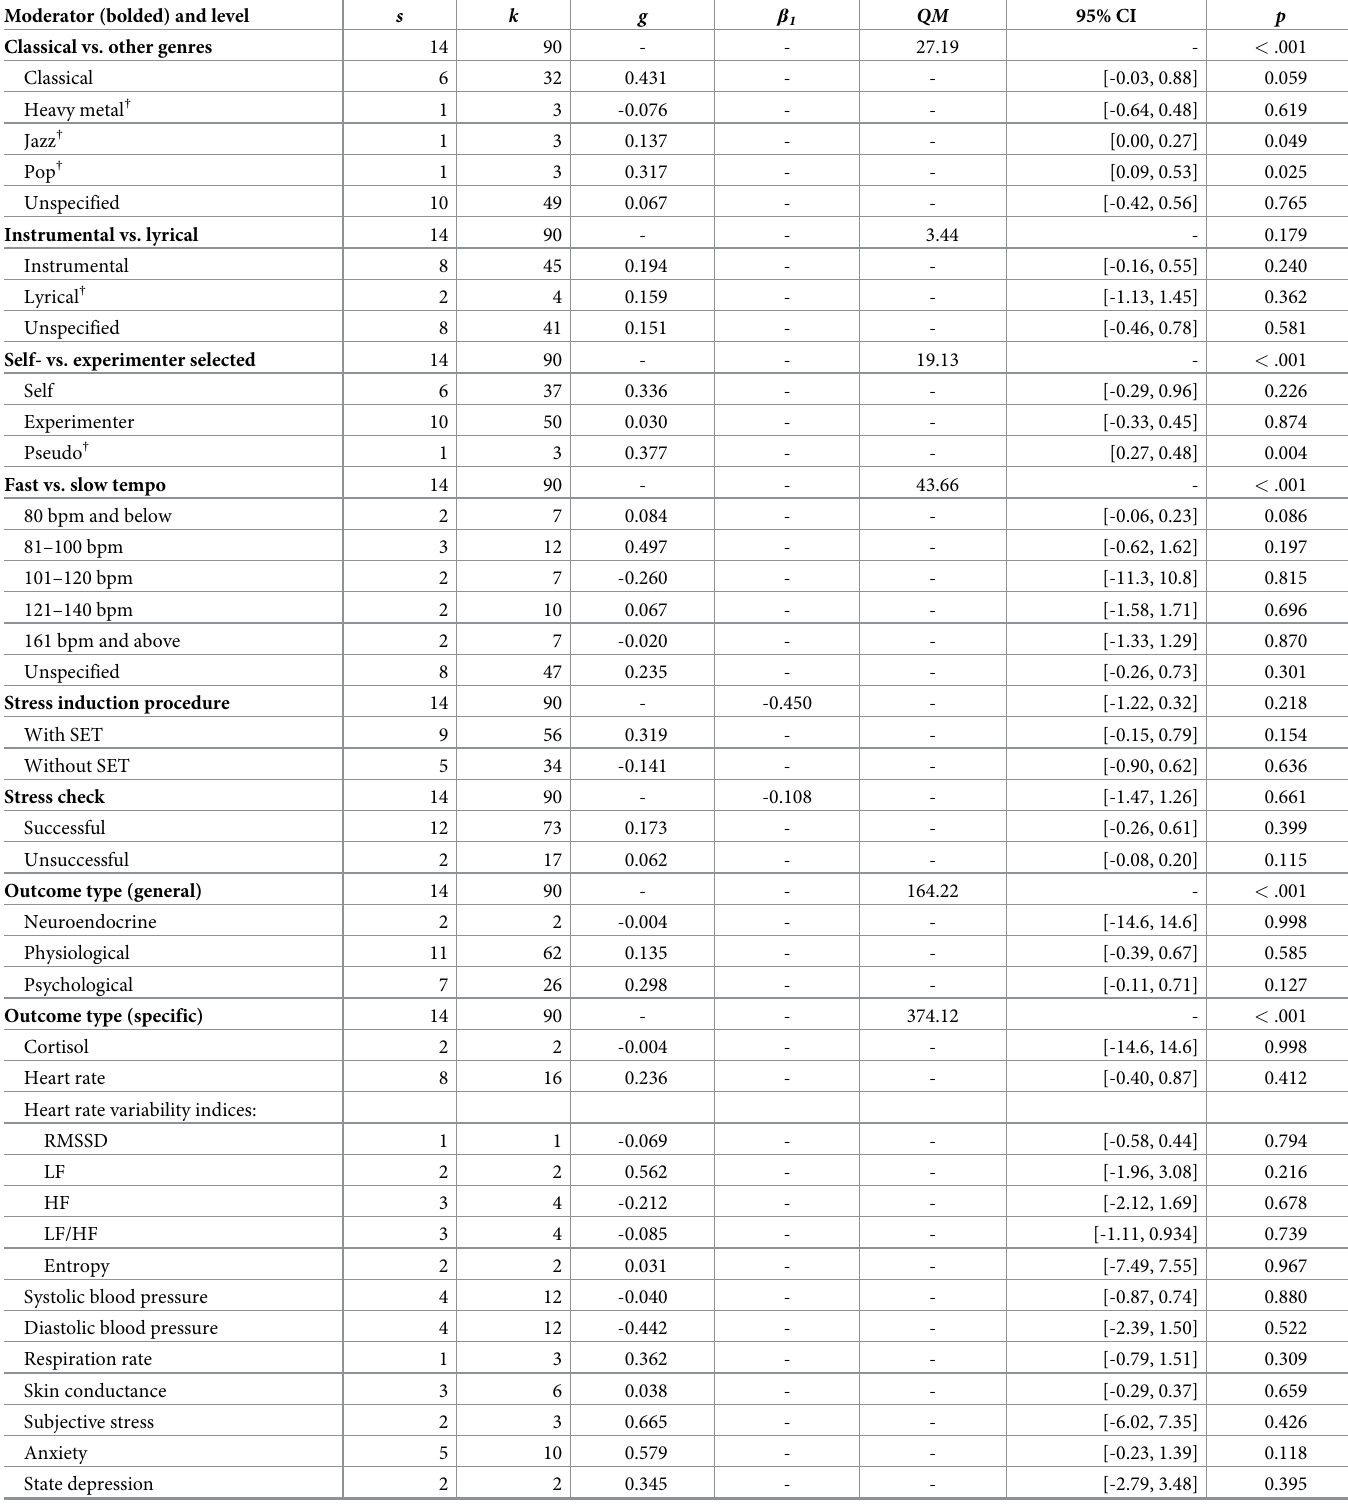
Table 3. Moderator